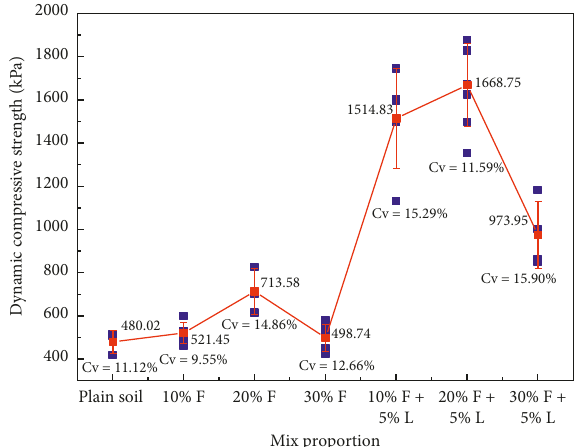
Figure 4: Dynamic compressive strength of stabilized soil with different mix proportions.